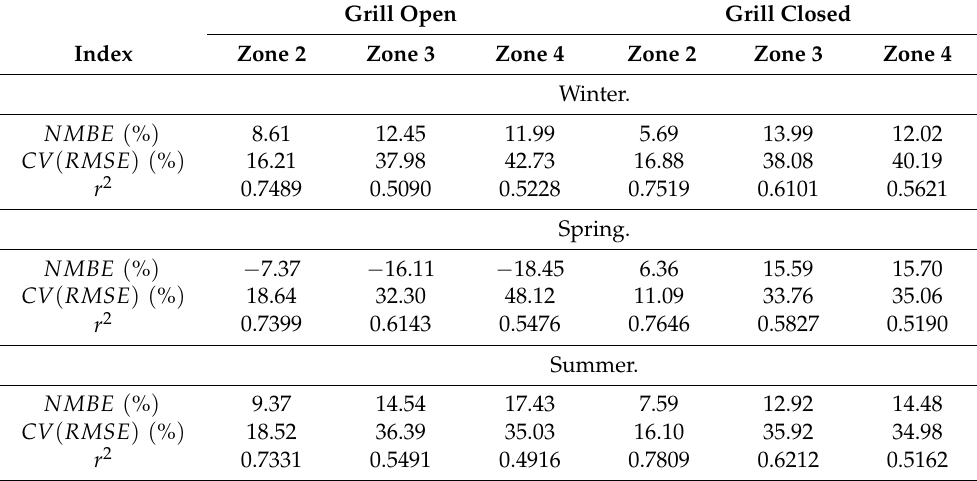
Table 10. Two-dimensional (2D) simulation. Values of the statistical indicators for air velocity.